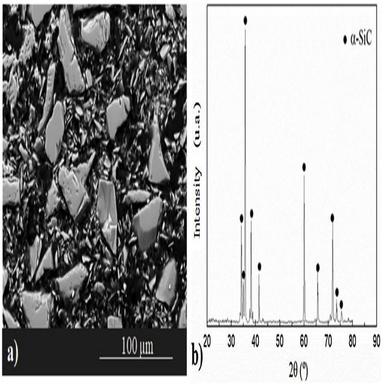
As received SiCp-C preform: a) Secondary electron micrograph after polishing and b) XRD pattern.